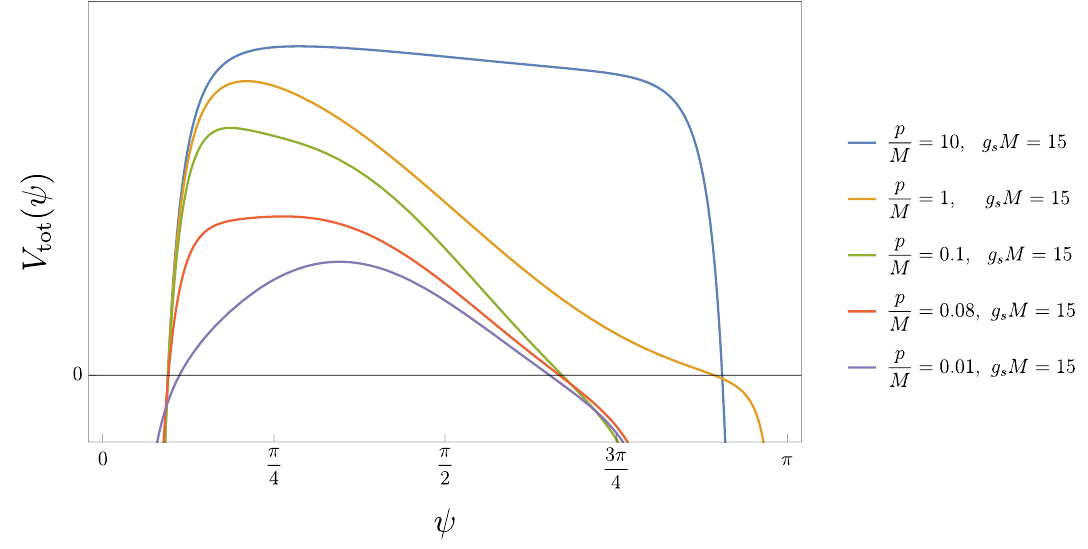
Figure 5. A plot of V tot ( ψ ) for different p/M showing the transition between the large and small p/M regime. The potentials at different p/M have been rescaled by choosing g s to make the comparison of their shape clearer.